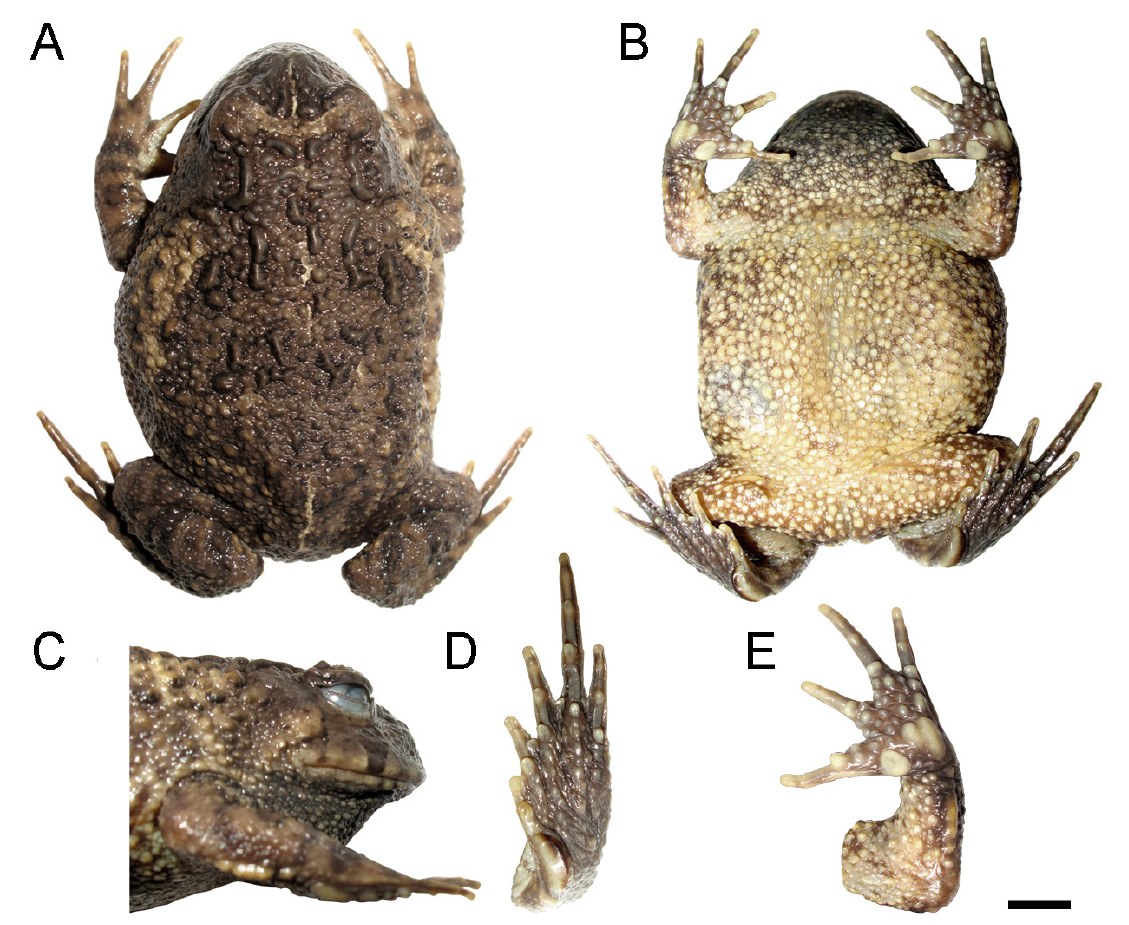
Fig. 1. Odontophrynus toledoi sp. nov., holotype, ♂ (ZUEC-AMP 24833). A . Dorsal view. B . Ventral view. C . Lateral view of the head. D . Ventral view of the foot. E . Ventral view of the hand. Scale bar = 5